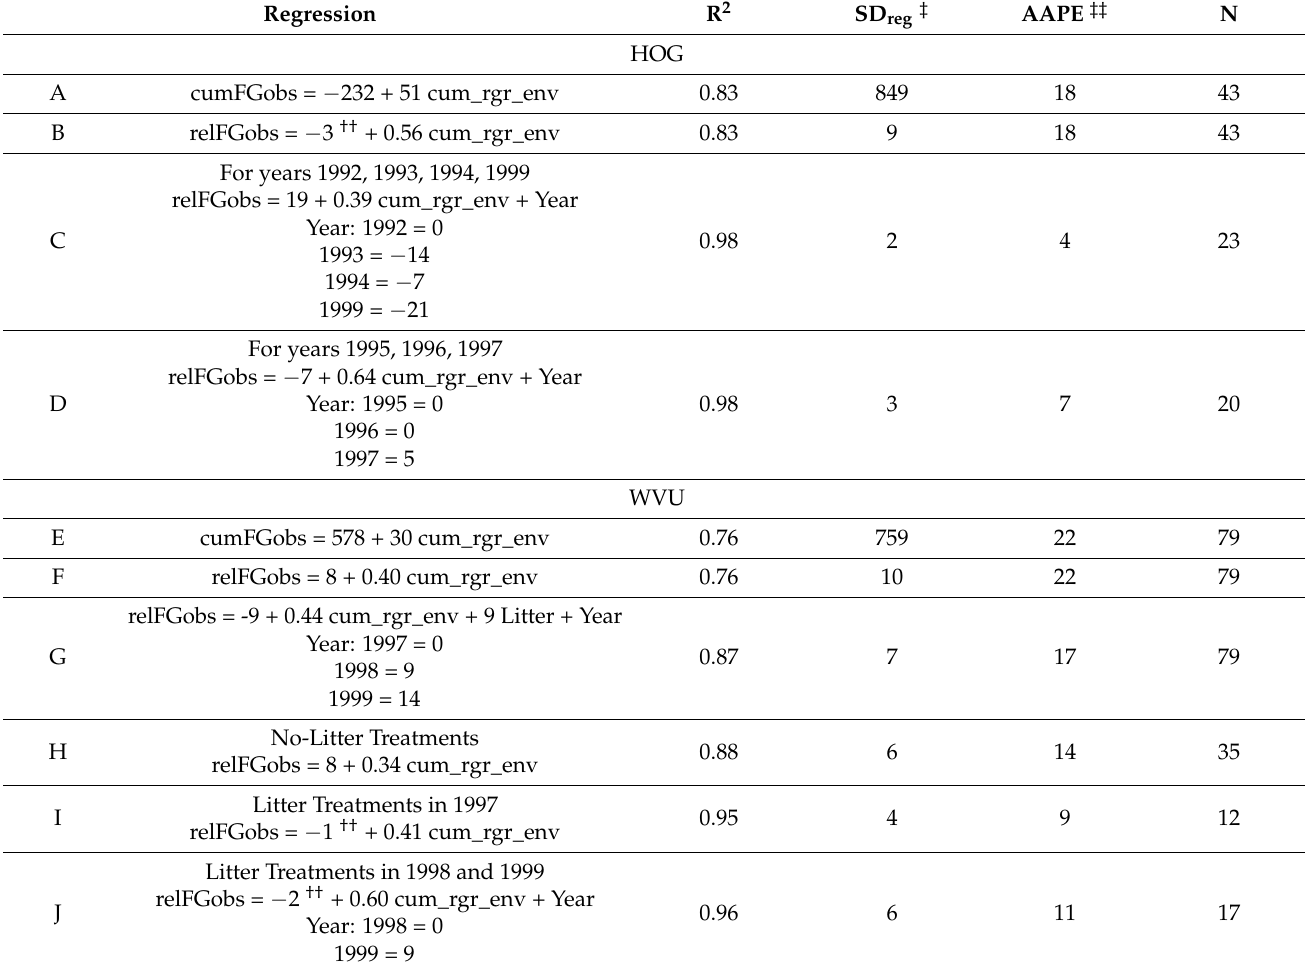
Table 1. Accuracy of the pasture growth model’s cumulative relative growth rate due to the environment (cum_rgr_env) for describing cumulative forage growth observed (cumFGobs, kg/ha) and relative forage growth observed (relFGobs † ) at two sites over multiple